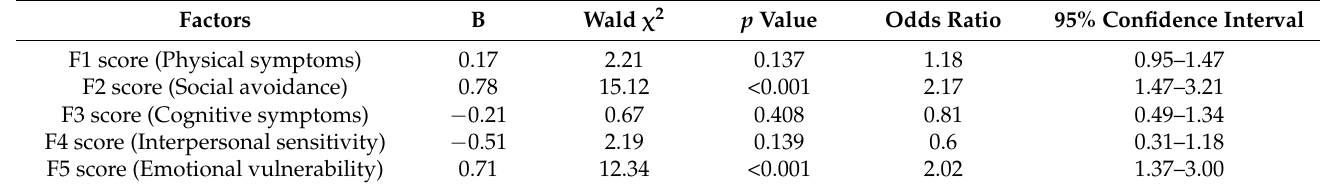
Table 4. Multivariable logistic regression models for suicidal ideation with the five